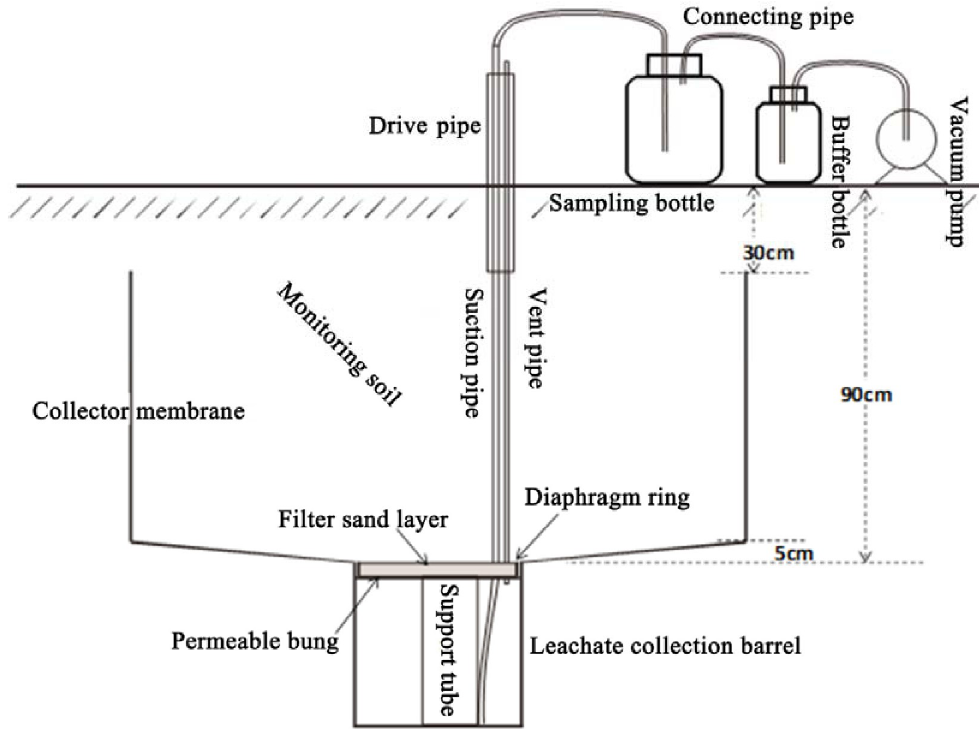
Fig 1. Set-up to collect